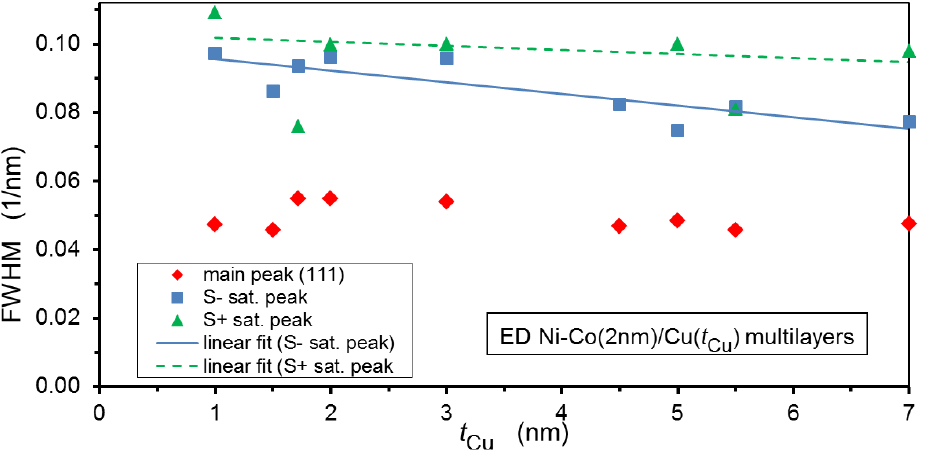
Figure 5. Full width at half maximum (FWHM) for the main (111) peak and the two satellite peaks around it for the present Ni-Co/Cu multilayers. The solid and dashed lines represent a linear fit to the S − and S + peak data, respectively.